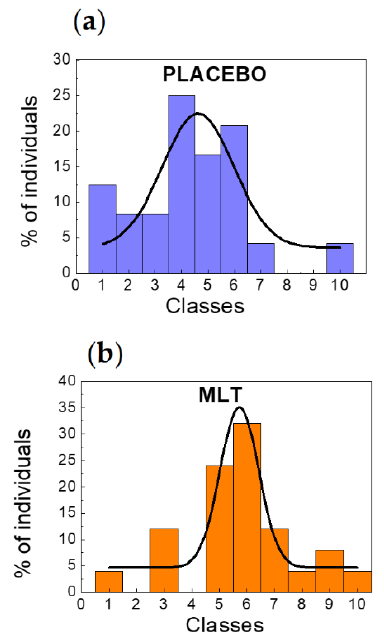
Figure 2. Individuals (%) vs. classes compared to a Gaussian fit distribution. ( a ) Percentage of individuals who have received placebo (blue histograms) and Gaussian distribution (black continuous curve). ( b ) As in ( a ) but for individuals who have received MLT (orange histograms). In both panels the meaning of classes in terms of leukocytes variation (in %) from the acrophase to the nadir is: 1 ⇔ positive variation, 2 ⇔ 0–5% negative variation, 3 ⇔ 5–10% negative variation, 4 ⇔ 10–15% negative variation, 5 ⇔ 15–20% negative variation, 6 ⇔ 20–25% negative variation, 7 ⇔ 25–30% negative variation, 8 ⇔ 30–35% negative variation, 9 ⇔ 35–40% negative variation, 10 ⇔ 40–45% negative variation.